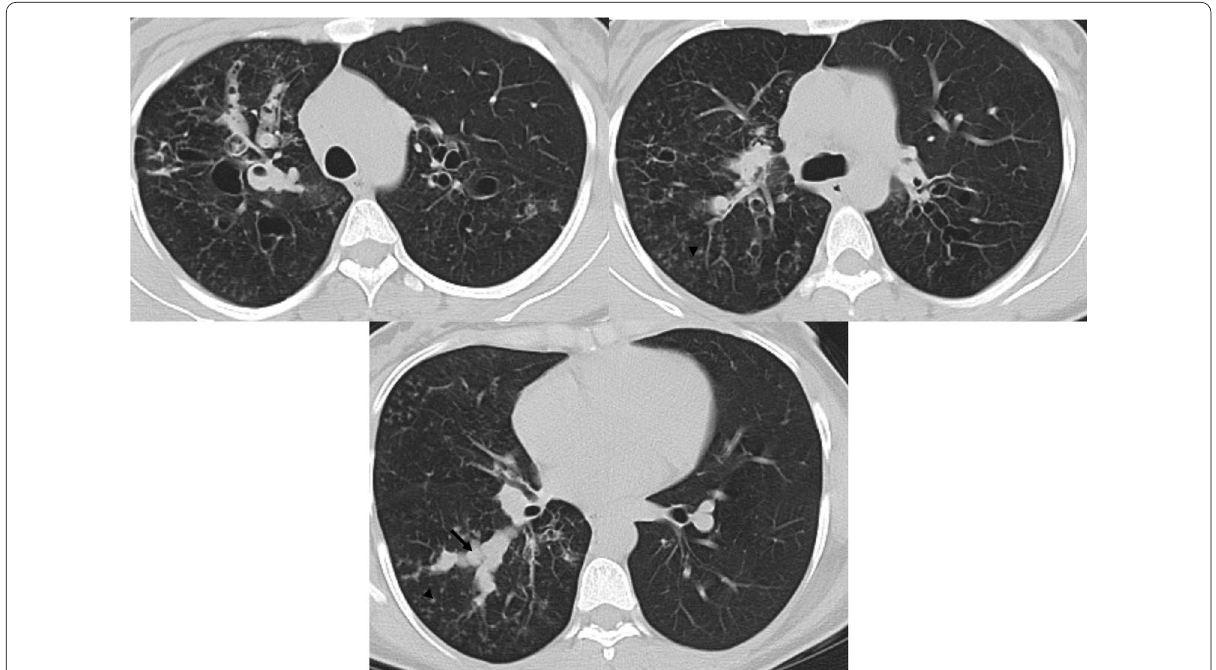
Fig. 6 A 31-year-old female presented with the chief complaints of cough with occasional blood in the sputum, shortness of breath and lethargy for 6 months and exacerbated since last 2 weeks. HRCT lungs sequential axial cuts showed bilateral mainly central bronchiectasis, with mucus blugging, multilobar well-defined centri-lobular nodules and tree-in-bud appearance. The laboratory, clinical and radiological diagnosis of fungal lung infection as ABPA was